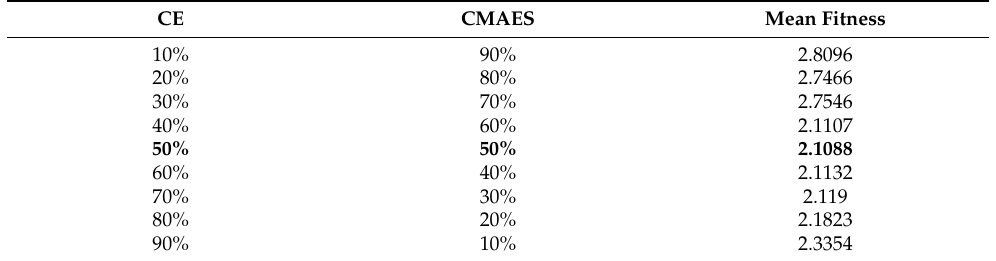
Table 4. Mean Fitness of CE-CMAES algorithm for a different contribution of iterations (%) in CE and CMAES.